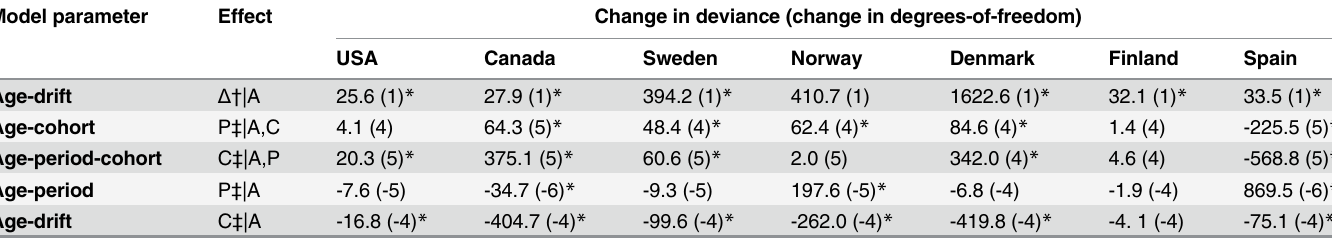
Table 2. Comparison of age-period-cohort sub-models for placental abruption prevalence